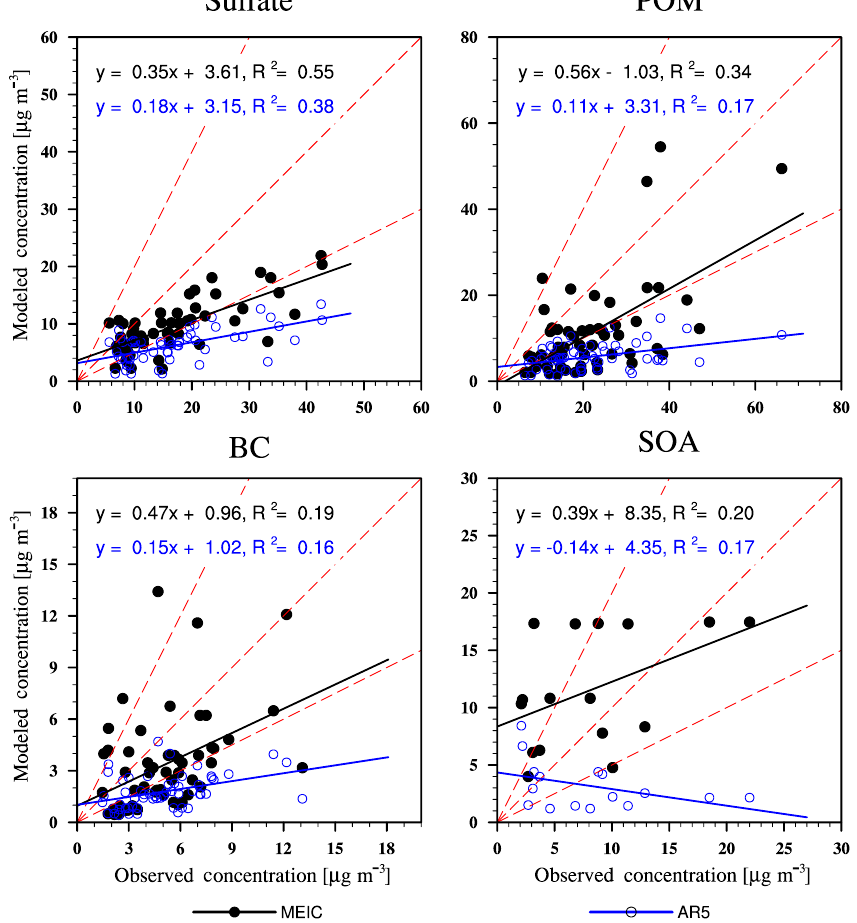
Figure 7. The monthly-average surface concentrations of sulfate, POM, BC, and SOA using the MEIC emission and the AR5 emission compared with observations. The solid lines are linear regressions between the model results and observations. The red dashed lines represent the 1 : 2, 1 : 1, and 2 : 1 lines. The regression functions and coefficients of determination ( R 2 ) are also